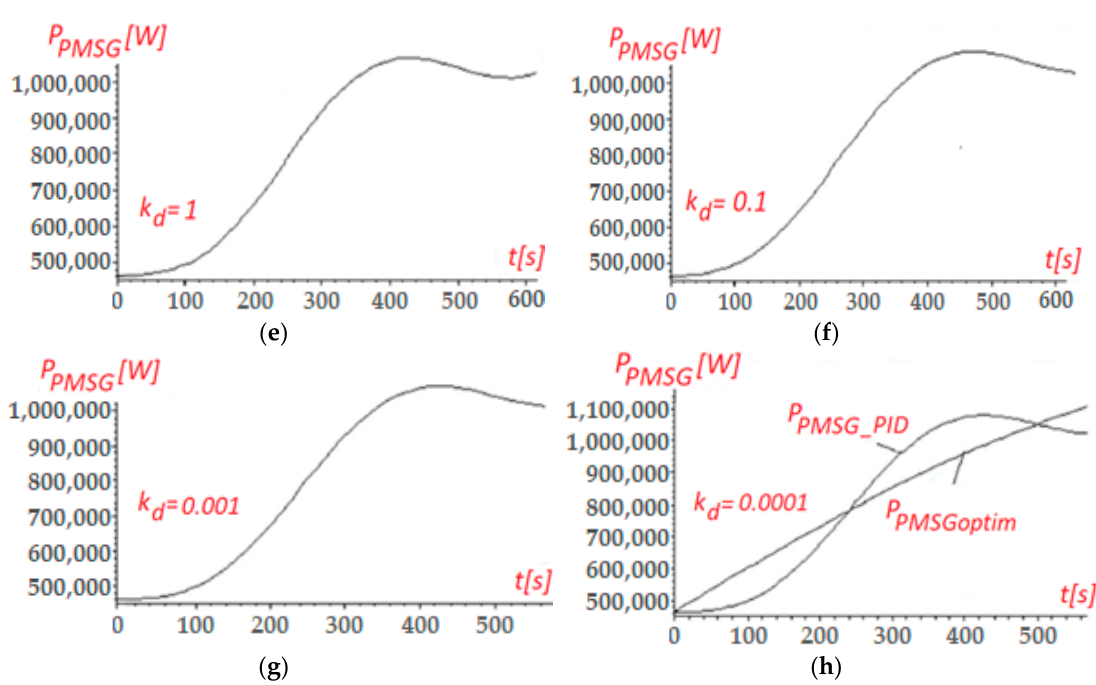
Figure (4). Time variation of the optimal PMSG‘s power curve, 𝑃 (cid:3017)(cid:3014)(cid:3020)(cid:3008)(cid:3042)(cid:3043)(cid:3047)(cid:3036)(cid:3040) (𝑡) for: (a). 𝑘 (cid:3031) = 10000 , (b). Figure 4. Time variation of the optimal PMSG‘s power curve, P PMSGoptim ( t ) for: ( a ). k d = 10000, 𝑘 (cid:3031) = 1000 ,(c). 𝑘 (cid:3031) = 100 , (d). 𝑘 (cid:3031) = 10 , (e). 𝑘 (cid:3031) = 1 , (f). 𝑘 (cid:3031) = 0.1 , (g). 𝑘 (cid:3031) = 0.001 , (h). 𝑘 (cid:3031) = 0.0001 . ( b ). k d = 1000, ( c ). k d = 100, ( d ). k d = 10, ( e ). k d = 1, ( f ). k d = 0.1, ( g ). k d = 0.001, ( h ). k d = 0.0001.